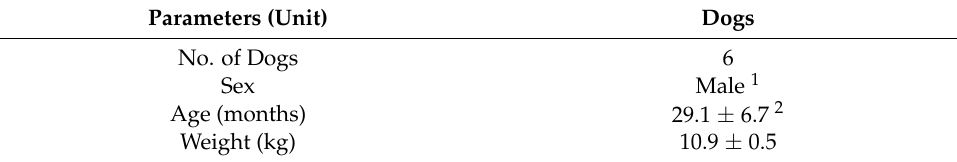
Table 1. Characteristics of study